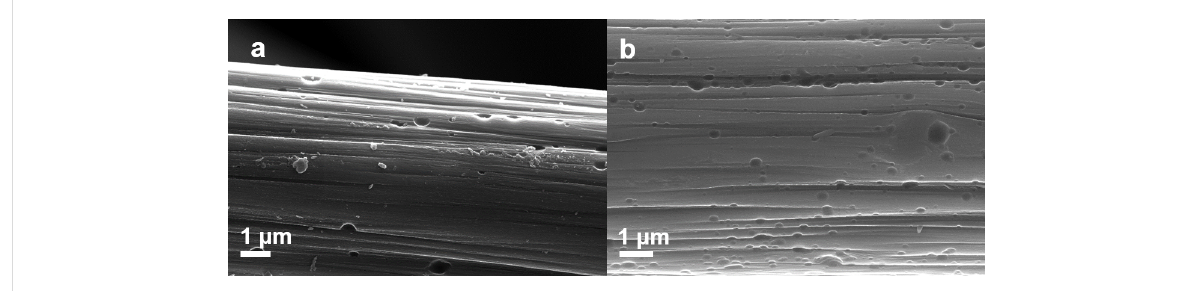
Figure 4: SEM images of a) pristine and b) N 2 -plasma-treated samples.